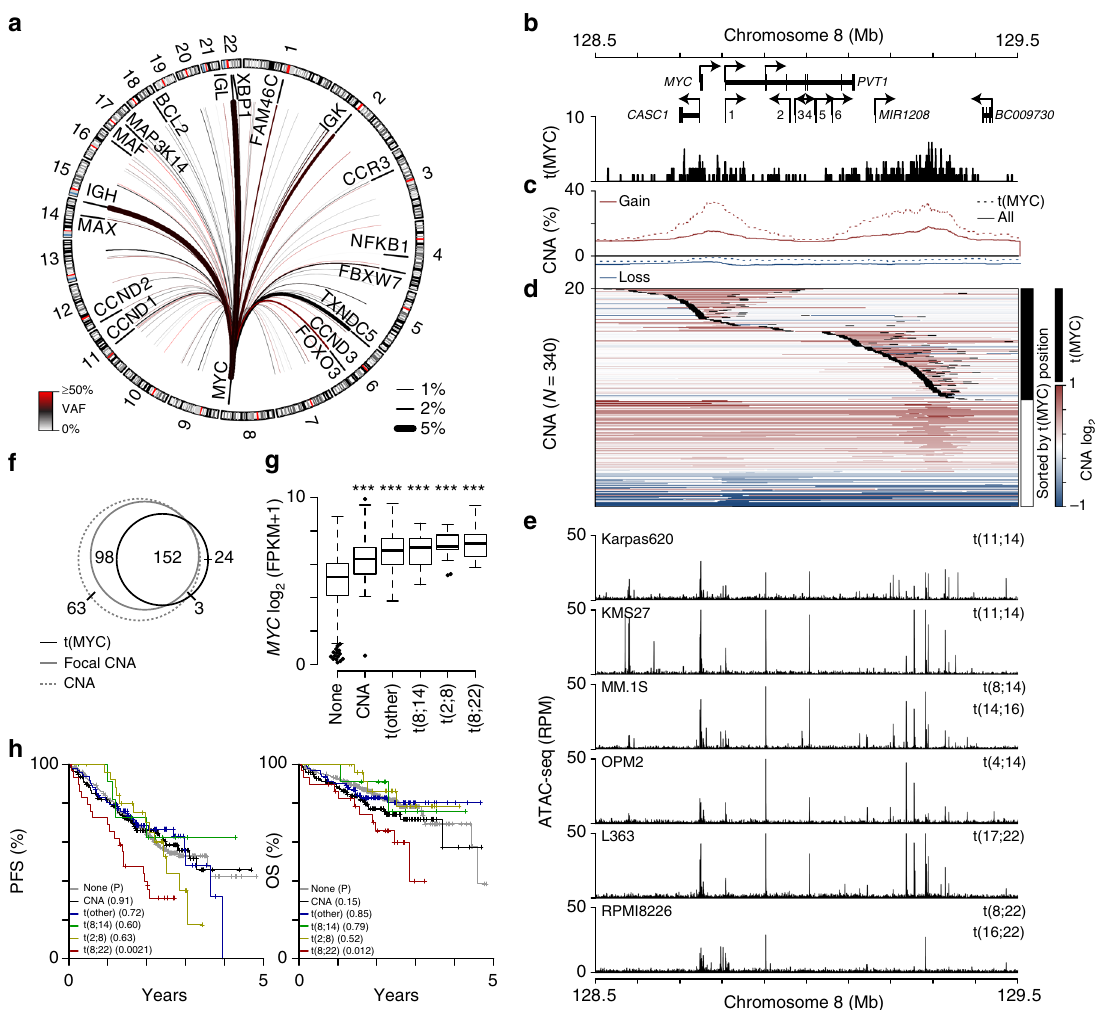
Fig. 3 MYC translocations correspond with focal ampli fi cations and aberrant expression. a Circos plot of MYC translocations in newly diagnosed myeloma ( N = 795). The median VAF and frequency of each translocation is denoted by the color and thickness of the line, respectively (see keys bottom left and right). b Genome (GRCh37) plot of the MYC locus showing genes (arrows indicate the direction of transcription; 1: MIR1204 , 2: TMEM75 , 3: MIR1205 , 4: U4 , 5: MIR1206 , 6: MIR1207 ), and the location of MYC translocations [t(MYC)]. c Frequency of copy number gains (red) and losses (blue) for all samples (solid line) and those with t(MYC) (dashed line). d A heatmap of copy number across the locus is shown for samples with either a MYC translocation (black) or only a CNA (white) sorted by the location of the MYC translocation, which are superimposed on the heatmap as 10 kb black regions. e ATAC- seq for 6 myeloma cell lines across the locus is shown below (RPM: reads per million). f Venn diagram of samples with a CNA at the MYC locus (dashed gray line), CNA boundary (solid gray line), or MYC translocation (black line). g Gene expression of MYC in samples with RNA-seq data ( N = 611) for patients with no MYC alteration (none; N = 382), MYC CNA only ( N = 83), MYC translocations to non-immunoglobulin genes [t(other); N = 81], IgH- MYC translocations [t(8;14); N = 27], IgK-MYC translocations [t(2;8); N = 13], and IgL-MYC translocations [t(8;22); N = 25]. *** P < 0.001, analysis of variance with Tukey ’ s post hoc test. Boxplots show the median and quartiles with the whiskers extending to the most extreme data point within 1.5 times the interquartile range. h Progression-free (PFS; left) and overall survival (OS; right) for patients strati fi ed by MYC structural variant type as in part g . P -values are shown in parenthesis and were calculated using a Cox proportional hazards Wald's test and denote the signi fi cance of survival differences relative to myelomas without a detectable MYC structural variant (none). Source data are provided as a Source Data fi le